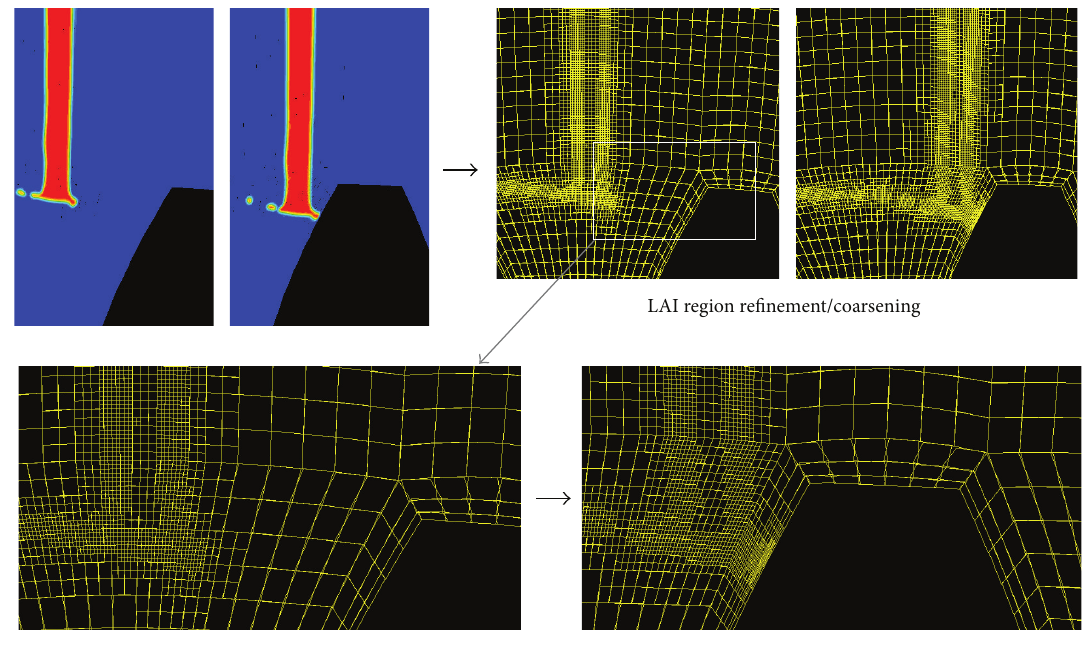
Figure 8: Mesh adaptation